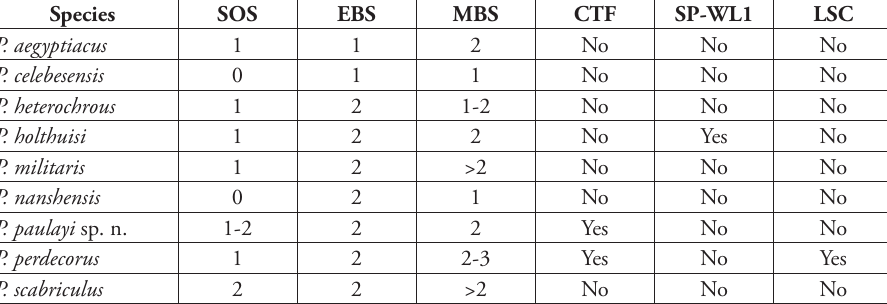
Table 1. Diagnostic characters for identification of the Petrolisthes species comprising the Indo-West Pacific mesobranchial-spine group. Diagnostic characters for identification of the Petrolisthes species com- prising the Indo-West Pacific mesobranchial-spine group. SOS = number of supraocular spines; EBS = number of epibranchial spines; MBS = number of mesobranchial spines; CTF = conspicuous